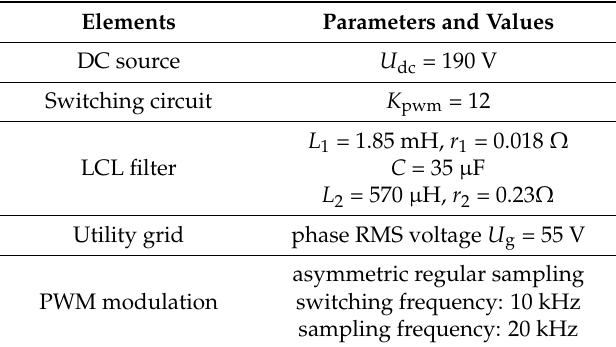
Table 2. Parameters of the experimental test bed.